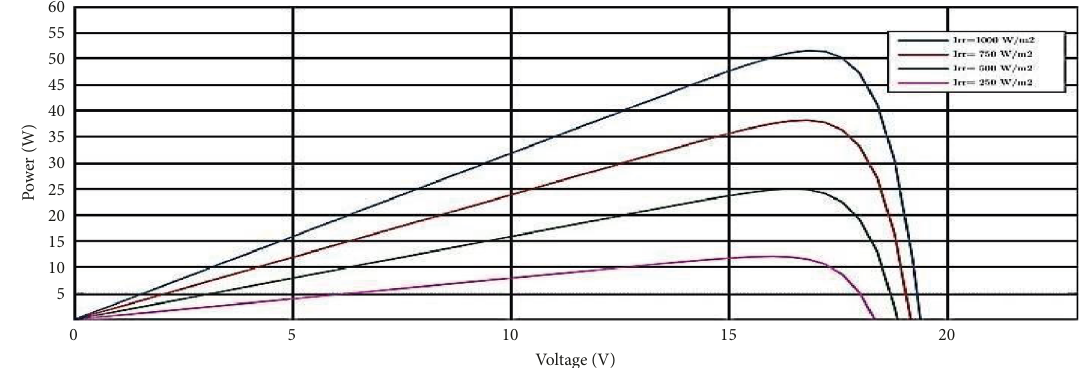
Figure 4: P–V parameters of a photovoltaic